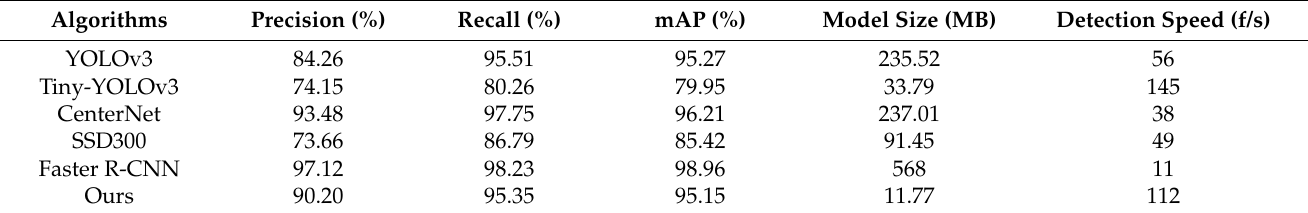
Table 6. UAV detection results obtained by different object detection